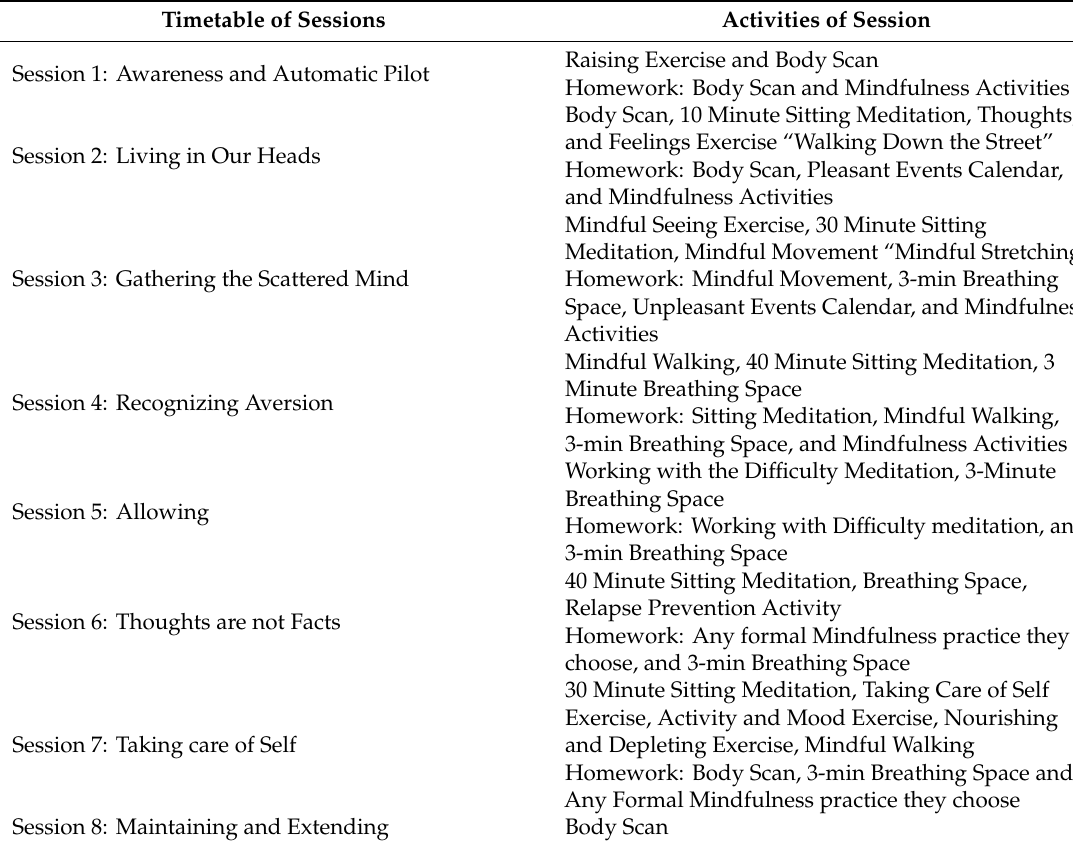
Table 1. Adapted mindfulness-based cognitive therapy. Timetable of Sessions Activities of